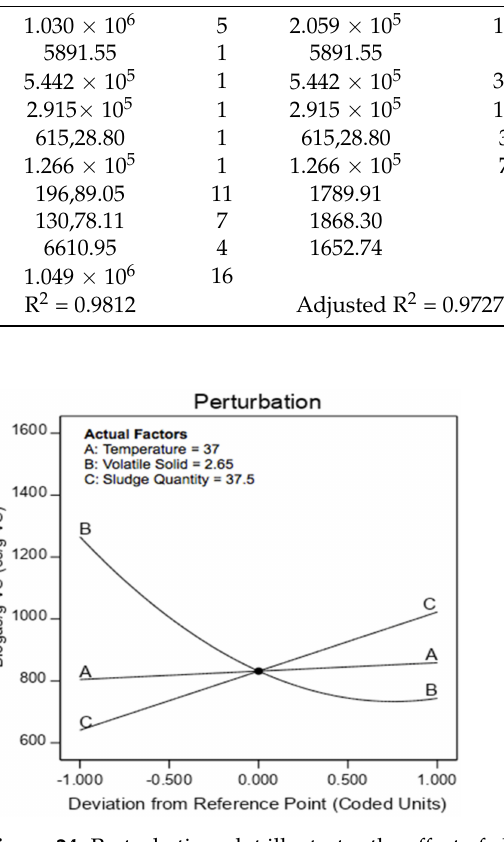
Figure 24. Perturbation plot illustrates the effect of all factors on the